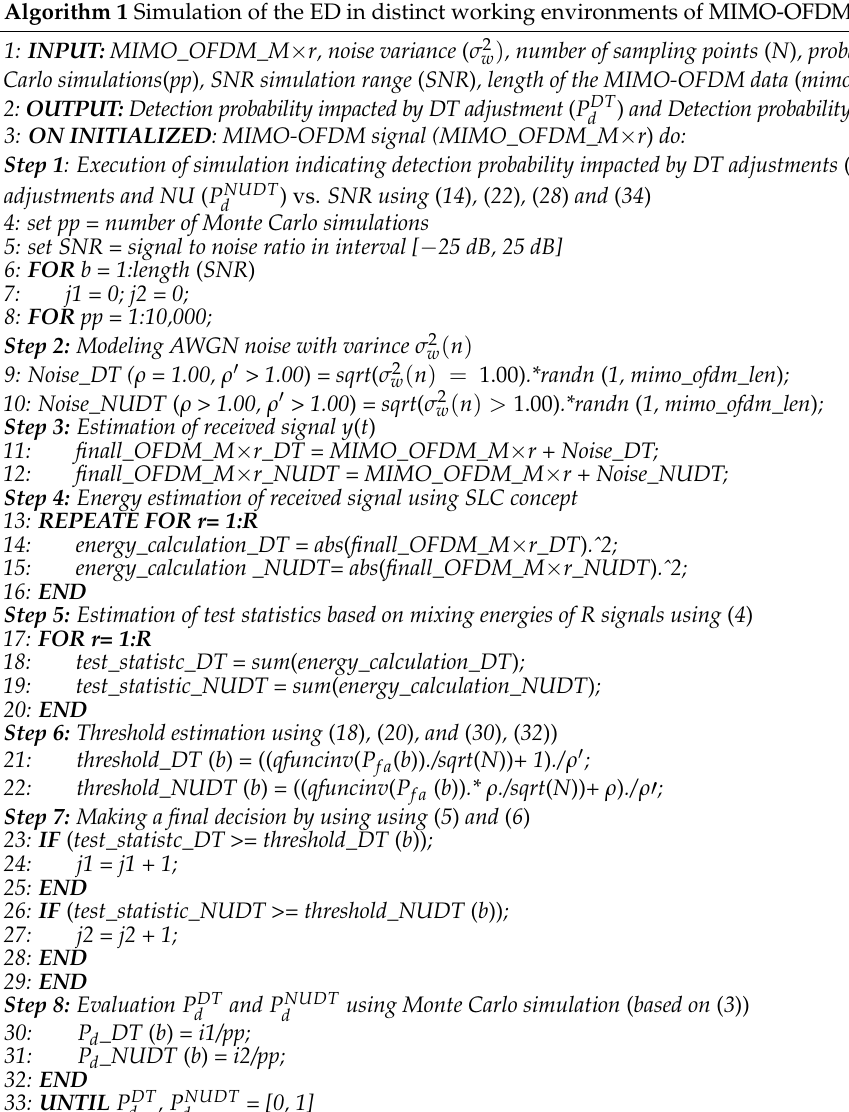
Algorithm 1 Simulation of the ED in distinct working environments of MIMO-OFDM CR systems.